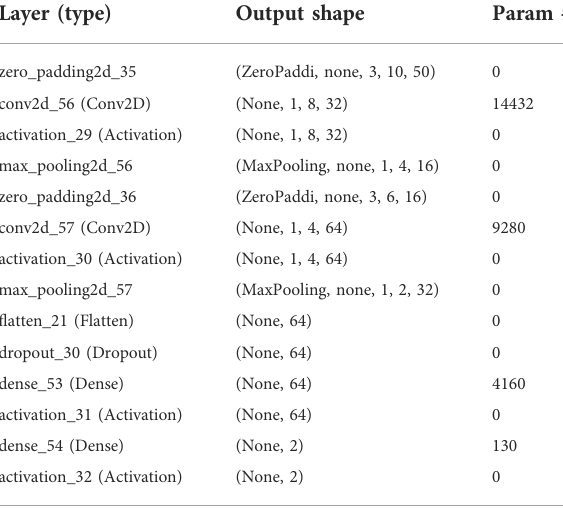
TABLE 2 Trainable parameters used in the 2D CNN